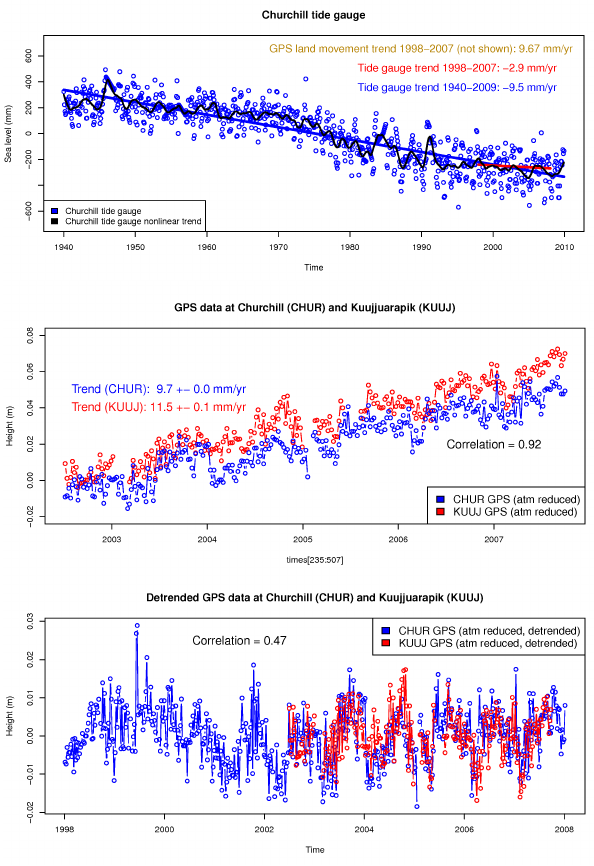
Fig. 10. The upper panel: sea level time series at tide gauge at Churchill; the middle panel: height time series and trends at GPS stations CHUR (Churchill) and KUUJ (Kuujjuarapik); the lower panel: detrended height time series at these GPS